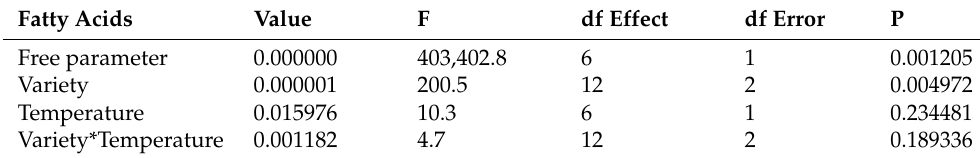
Table 4. The results of the MANOVA multivariate test of fatty acids (method: Wilks test). Fatty